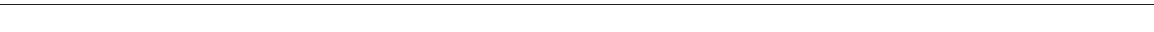
Fig. 2 Defective myotube formation by PIEZO1-de fi cient myoblasts. a – d Aberrant morphologies of PIEZO1-de fi cient myotubes. a Syncytia formed by WT and PIEZO1-de fi cient C2C12 myoblasts were visualized by immuno fl uorescent staining with anti-MyHC antibody (differentiated cells, red) and DAPI (nuclei, cyan). b Left: cell fusion evaluated as percentages of syncytia containing ≥ 50 nuclei in a . Right: polarized elongation evaluated as percentages of syncytia with aspect ratios ≥ 3 in a . c Syncytia formed by human primary myoblasts transfected with control or PIEZO1 siRNA were visualized by immuno fl uorescent staining with anti-MyHC antibody (differentiated cells, red) and DAPI (nuclei, cyan). d Left: cell fusion evaluated as percentages of syncytia containing ≥ 16 nuclei in c . Right: polarized elongation evaluated as percentages of syncytia with aspect ratios ≥ 3 in c . e , f Mislocalization of cortical actomyosin in PIEZO1-de fi cient myotubes. e Localization of F-actin (phalloidin, red) and NMIIA (anti-NMIIA antibody, green) at the cell periphery of WT and PIEZO1-de fi cient C2C12 syncytia. Arrows indicate PIEZO1-de fi cient syncytia with diminished peripheral accumulation of NMIIA. f Cortex vs. cytoplasm ratio of F-actin and NMIIA signals in e . g , h Normal cell surface expression of PIEZO1 in PS fl ippase-de fi cient myoblasts. g Co-localization of GFP-tagged ATP11A (magenta) and FLAG-tagged PIEZO1 (green) in WT C2C12 myoblasts. Merged images and signal intensities are shown in the bottom panels. h Co-localization of GFP-tagged PIEZO1 (anti-GFP antibody, green) and F-actin (phalloidin, magenta) at the cell periphery of WT, CDC50A- de fi cient and ATP11A-de fi cient C2C12 myoblasts. Merged images are shown in the bottom panel. **** P < 0.0001 (Student ’ s t -test). n sample number. Bar graphs represent mean ± S.E.M. Box and whiskers graph-line: median, box: upper and lower quartiles, whiskers: maxima and minima. Scale bars: 100 μ m ( a , c ), 20 μ m ( e ), 10 μ m ( g , h